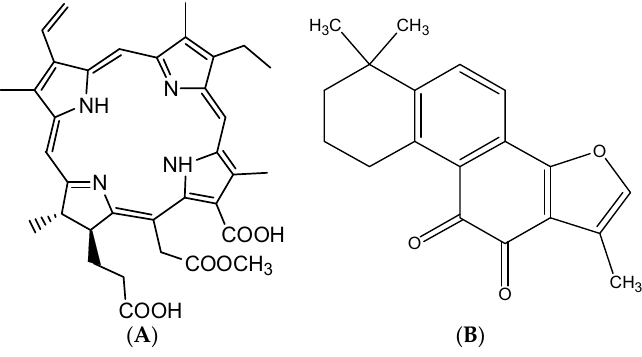
Figure 1. Chemical structures of ( A ) CMME; ( B ) Tanshinone IIA (IS).